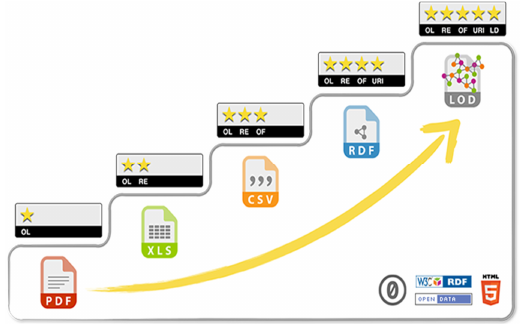
Figure 6: The 5-Star Model (from http://5stardata.info/en/)